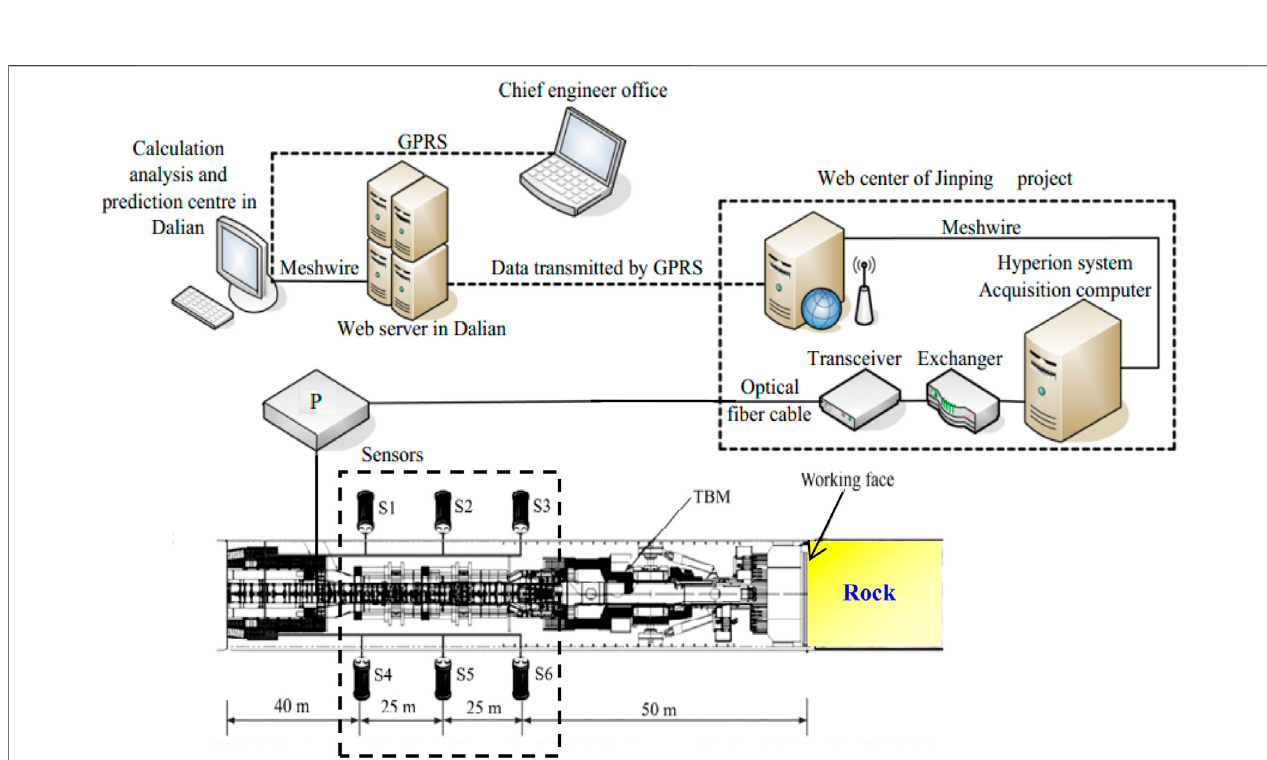
FIGURE 3 | Microseismic monitoring system for ground tunnels in Jinping hydropower station (Yu et al., 2014).